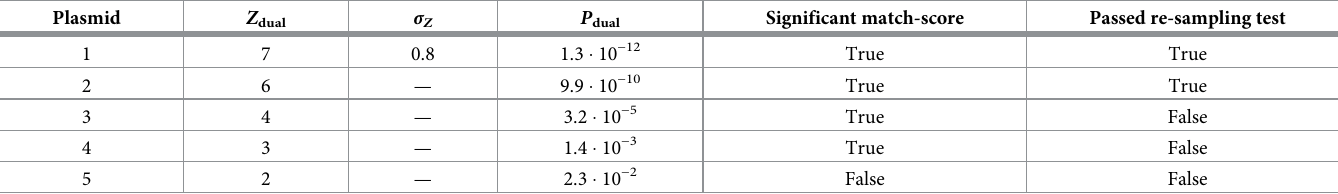
Table 2. Fictional example of how five plasmids sorted by match-score Z would be separated into the two levels of precision: ‘Significant match-score’ and ‘passed resampling test’. In this table five imaginary plasmids have been sorted by match-score Z . The top 4 plasmids are found to have P dual � 0.01, i.e., these plasmids are deemed to have statistically significant match scores. However, only the top 2 plasmids are considered to pass the resampling test, where a 3- σ plasmid where the difference in match-score, compared to the top case, is deemed to be too large.